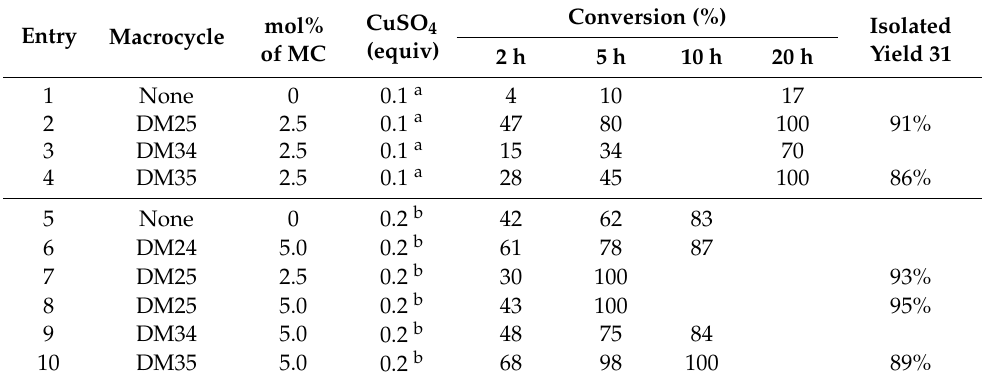
Table 5. Effect of the macrocycles on copper-mediated click reaction of sugar azide with 4-tert- butylphenylacetylene (R = p - t -Bu-C 6 H 4 -).